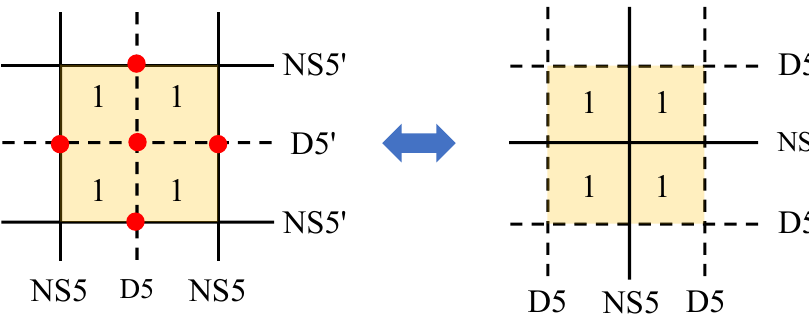
= (0 , 4) U(1) gauge theory with a charged N